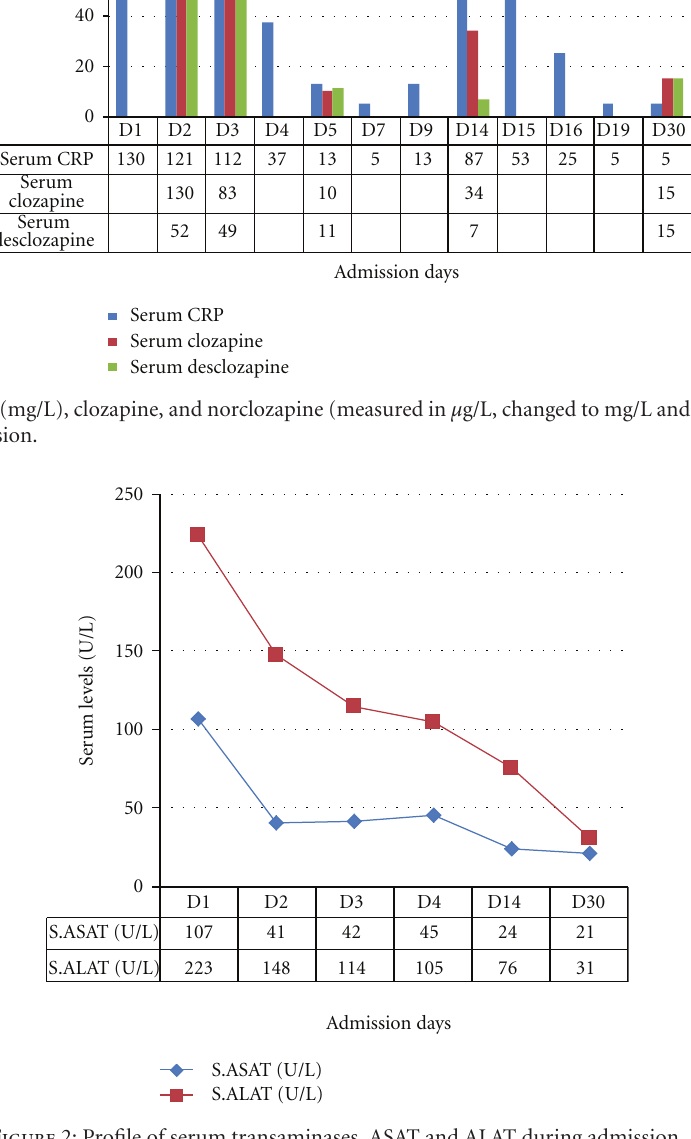
Figure 2: Profile of serum transaminases, ASAT and ALAT during